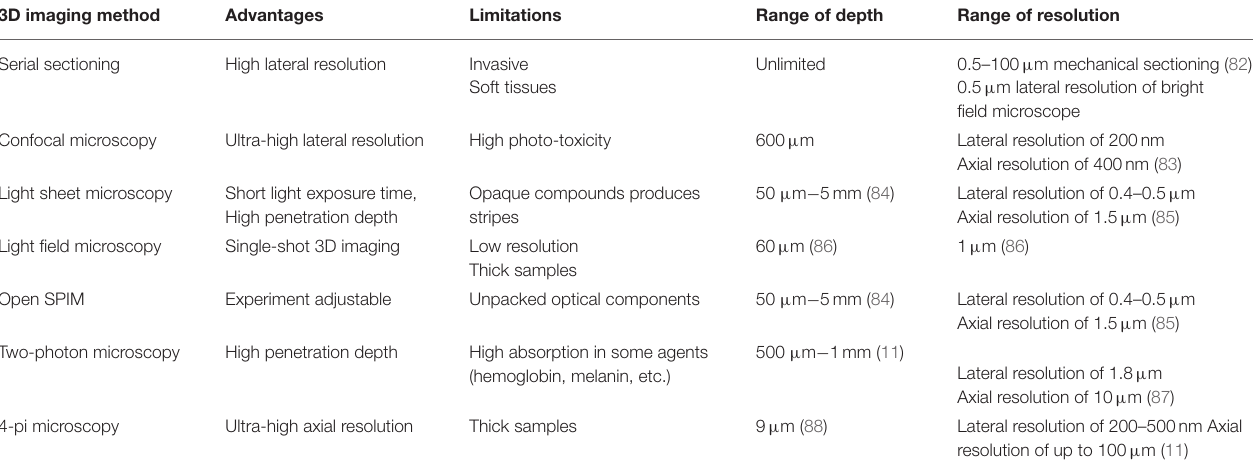
TABLE 4 | Review of 3D optical imaging method.